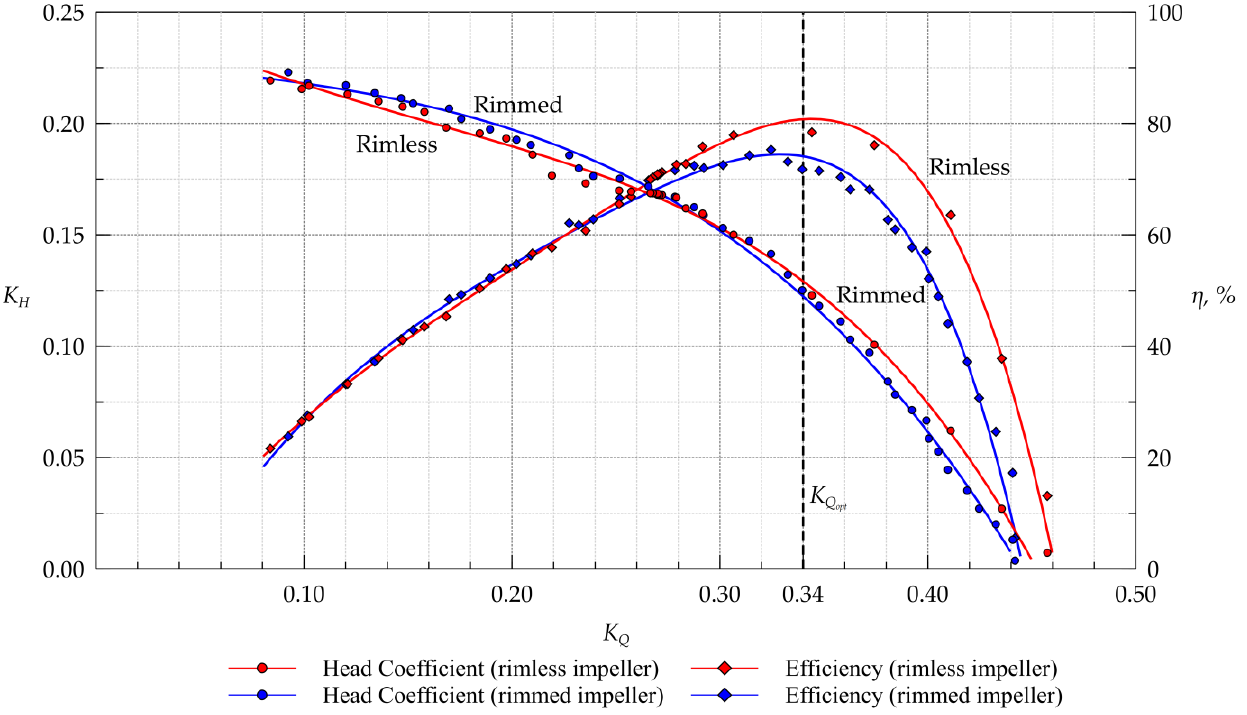
Figure 6. Experimental energy characteristics of the axial pump № 2 with rimmed and rimless im-